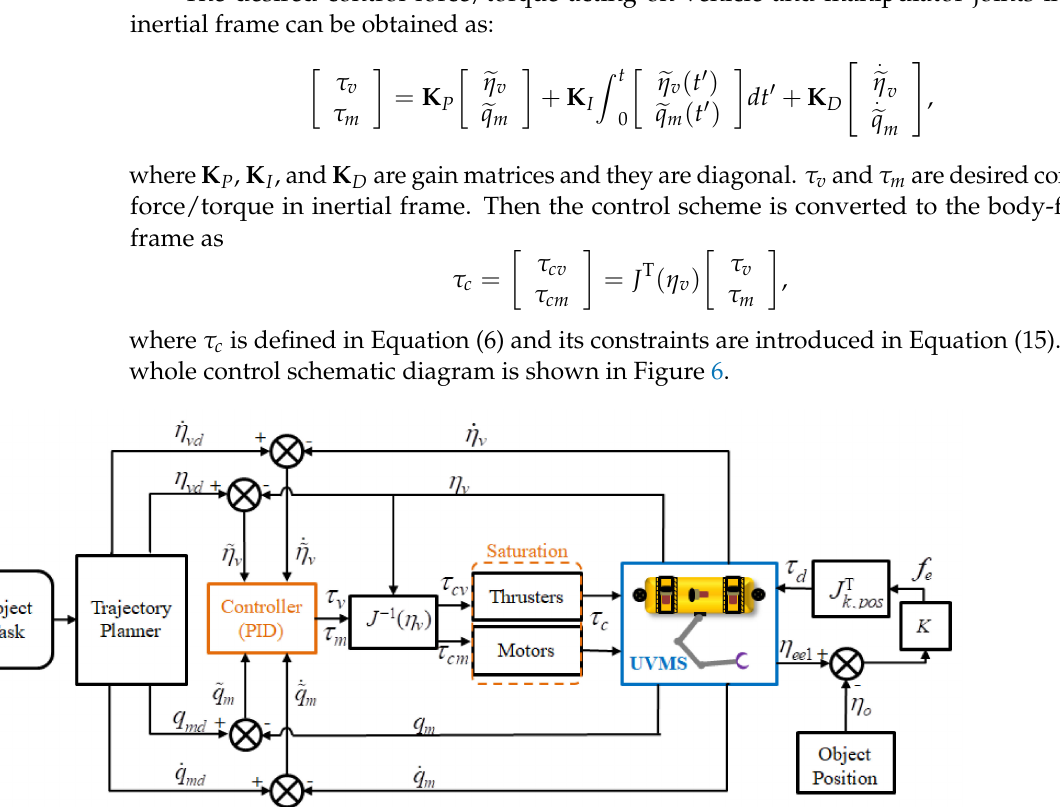
Figure 6. Schematic diagram of the UVMS control